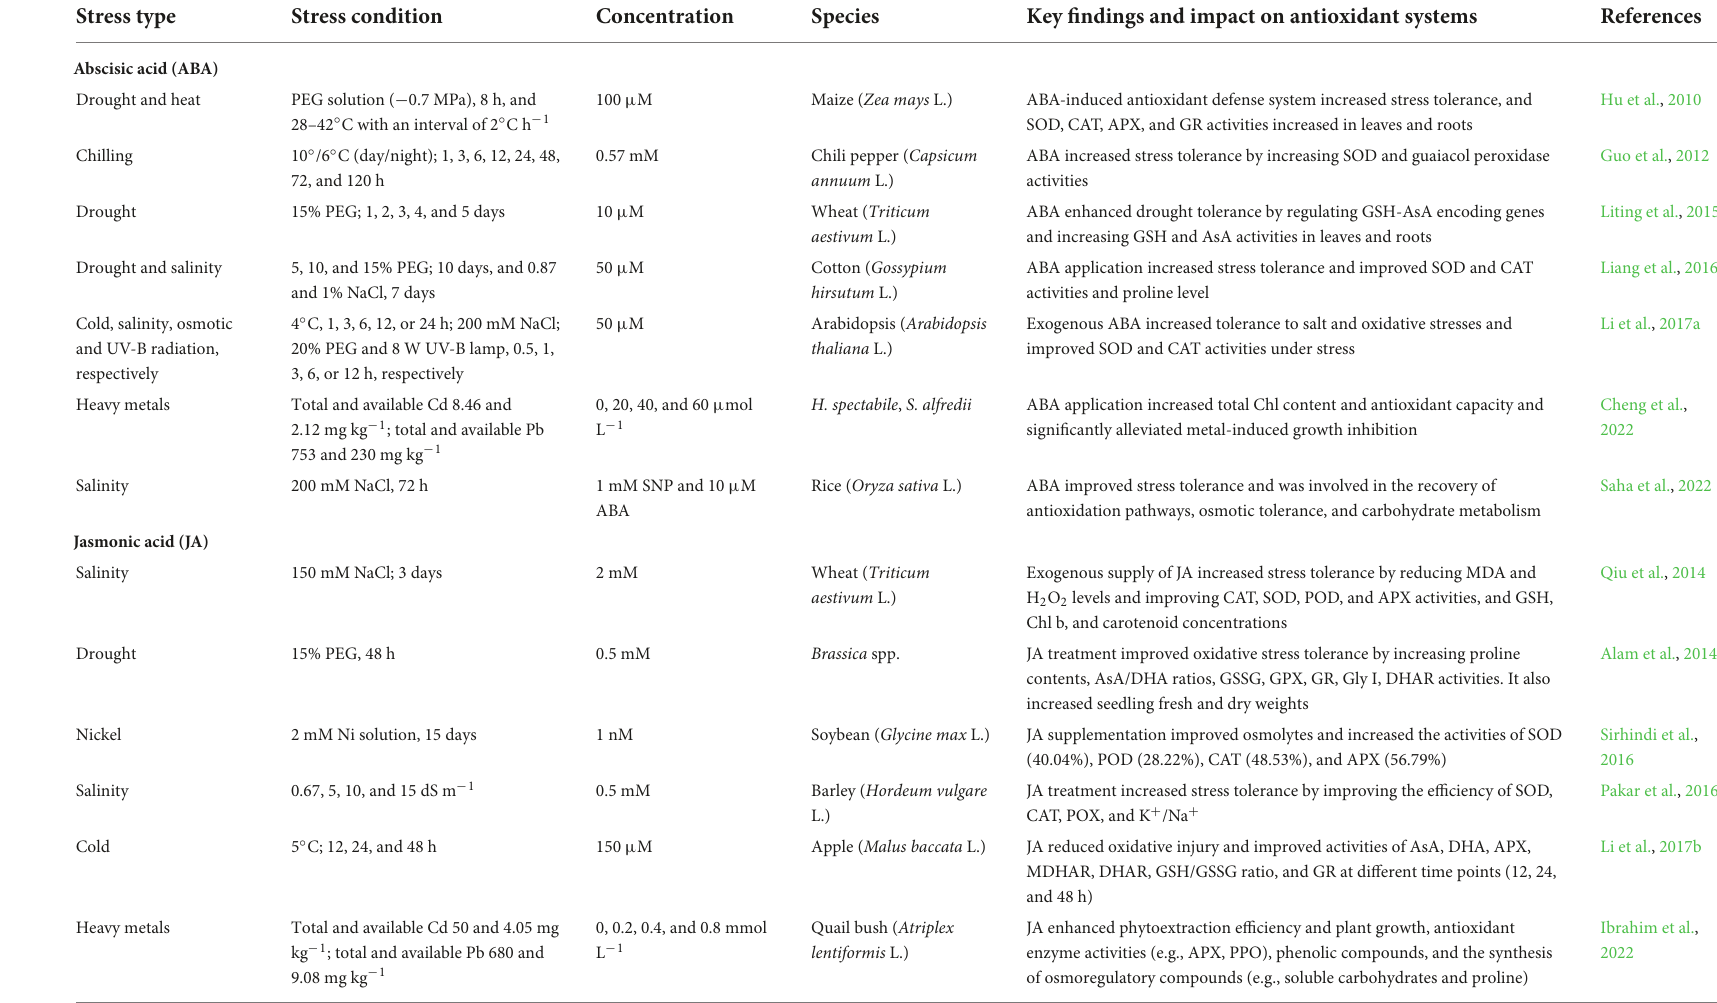
TABLE 1 Application of some major plant hormones to plants under stress and their impact on antioxidant systems. Notably, all presented studies increased stress tolerance and improved plant health. Abbreviations are explained in the